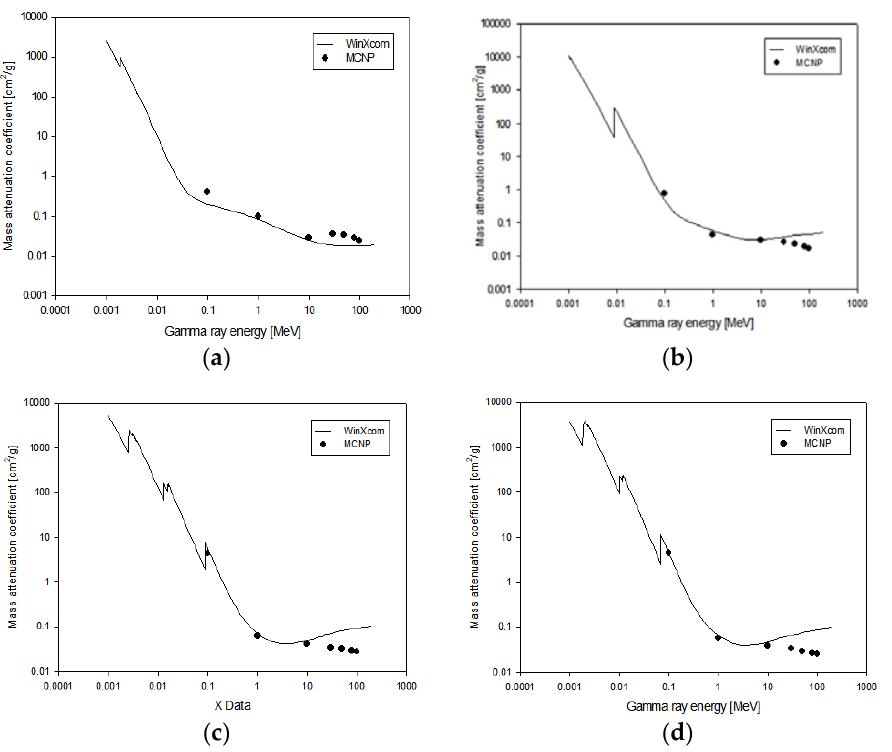
Figure 4. Mass attenuation coefficient of concrete at WinXcom and MCNP; ( a ) Concrete, ( b ) Copper, ( c ) Lead, ( d ) Tungsten.